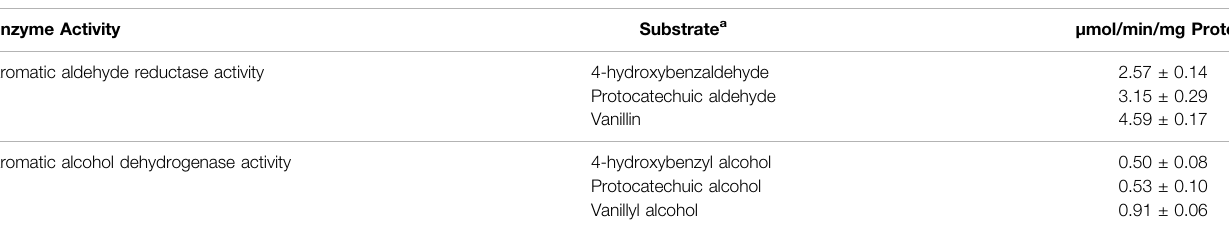
TABLE 2 | Speci fi c activity of the NCgl0324 enzyme for aromatic aldehydes and alcohols. Enzyme